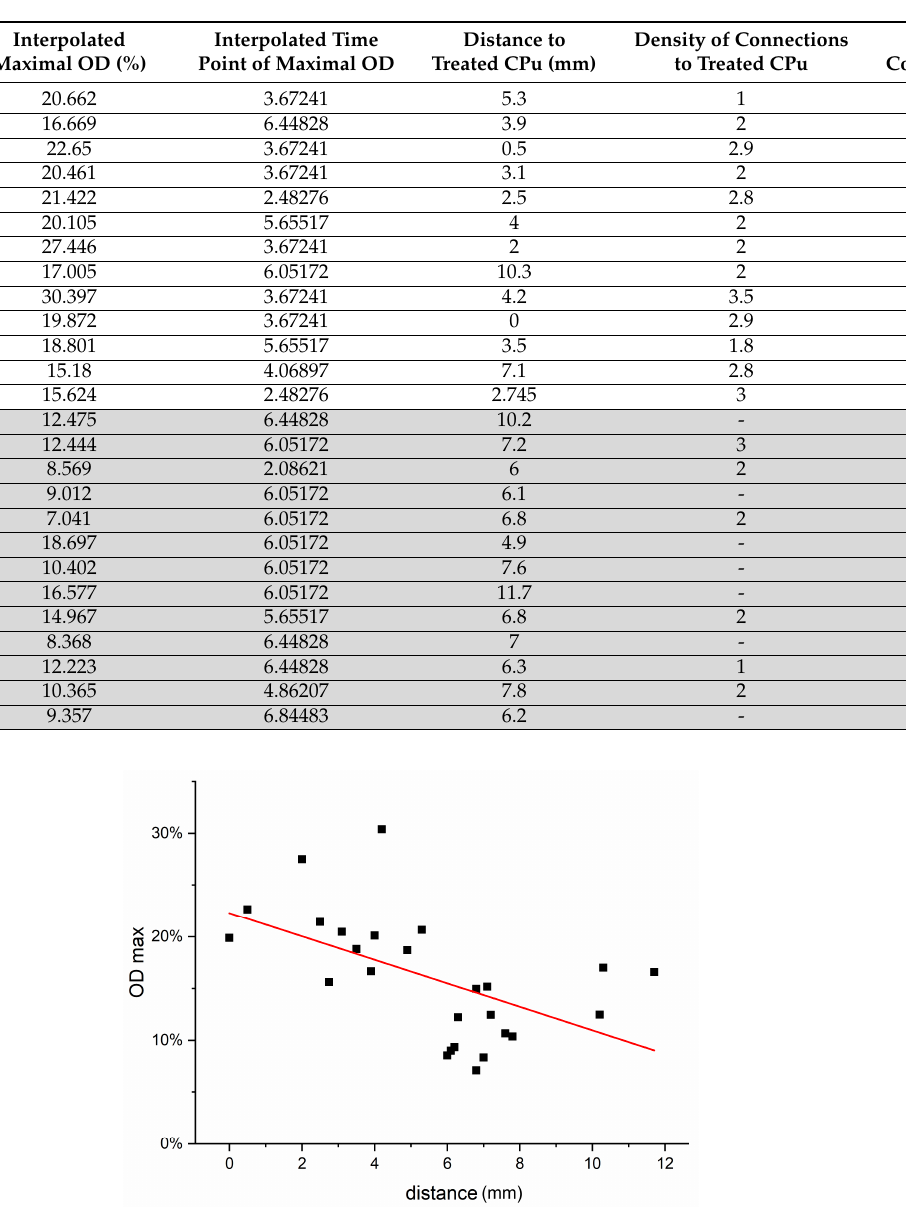
Table 2. The table lists the virtual maximal OD, the time points for the occurrence of the virtual maximal OD, the distances of their gravitational centers with that of the treated CPu, and the density of connections with the treated CPu for all brain areas studied. The lines with a gray background contain the values of the brain areas from the contralateral hemisphere. The distances and the connection densities were taken from the program neuroVIISAS.